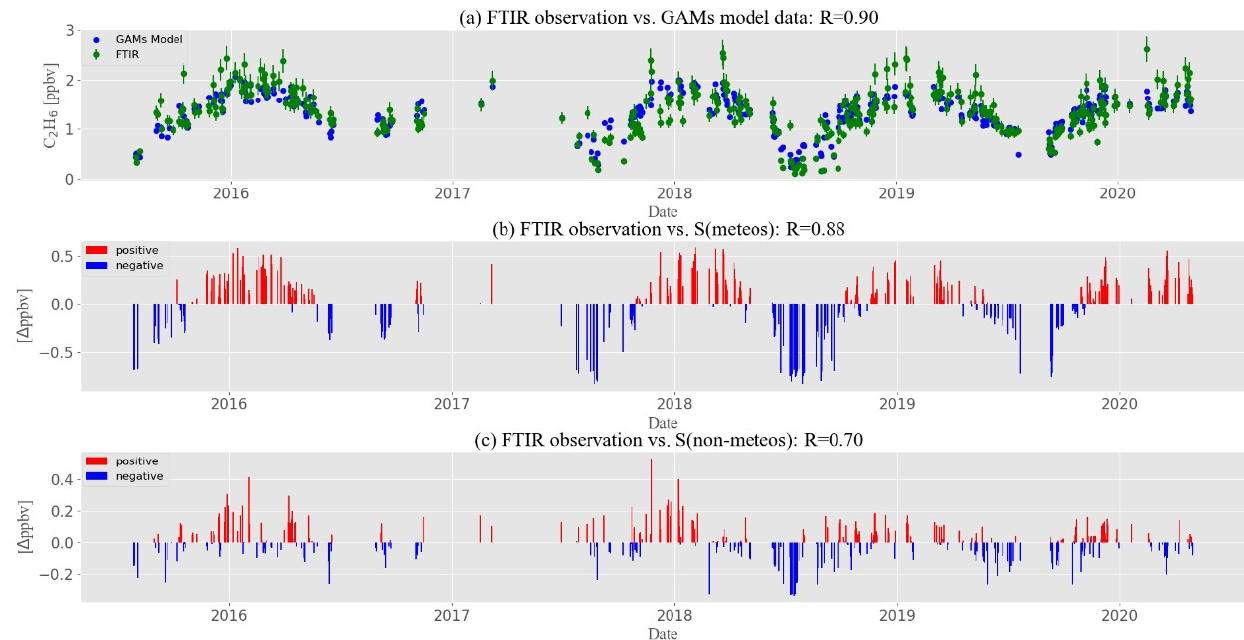
Figure 4. (a) C 2 H 6 troDMF time series from 2015 to 2020 over Hefei, eastern China, from FTIR and the GAMs regression model. (b) Time series of accumulated meteorological smooth functions, S( meteos ) ; (c) time series of accumulated emission smooth functions, S( non-meteos ) . Positive and negative influences are indicated using red and blue bars, respectively. Correlation coefficients for the total, meteorological, and emission influences are also shown.